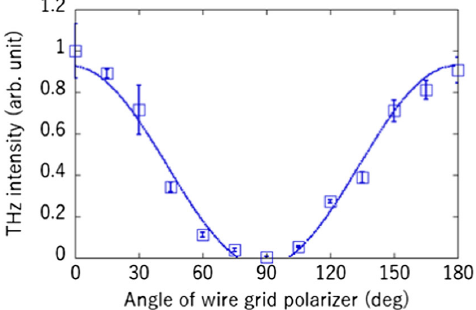
FIG. 8. Polarization characteristic of the CChR pulse measured using a wire grid pair and a THz camera. The solid curve is the best-fitted curve to the data. Error bars represent the fluctuation of THz intensity with standard errors statistically processed by five data of THz camera image.